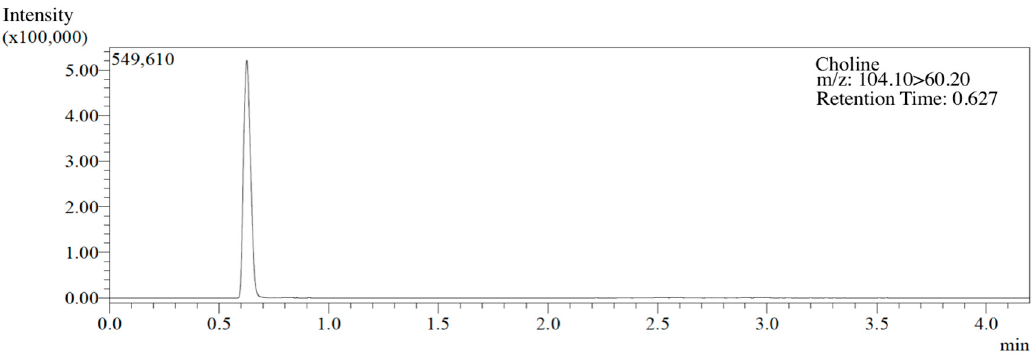
Figure 1. UPLC/MS/MS chromatogram of a Stachys sieboldii MIQ extract containing Figure 1. UPLC/ MS/MS chromatogram of a Stachys sieboldii MIQ extract containing choline.